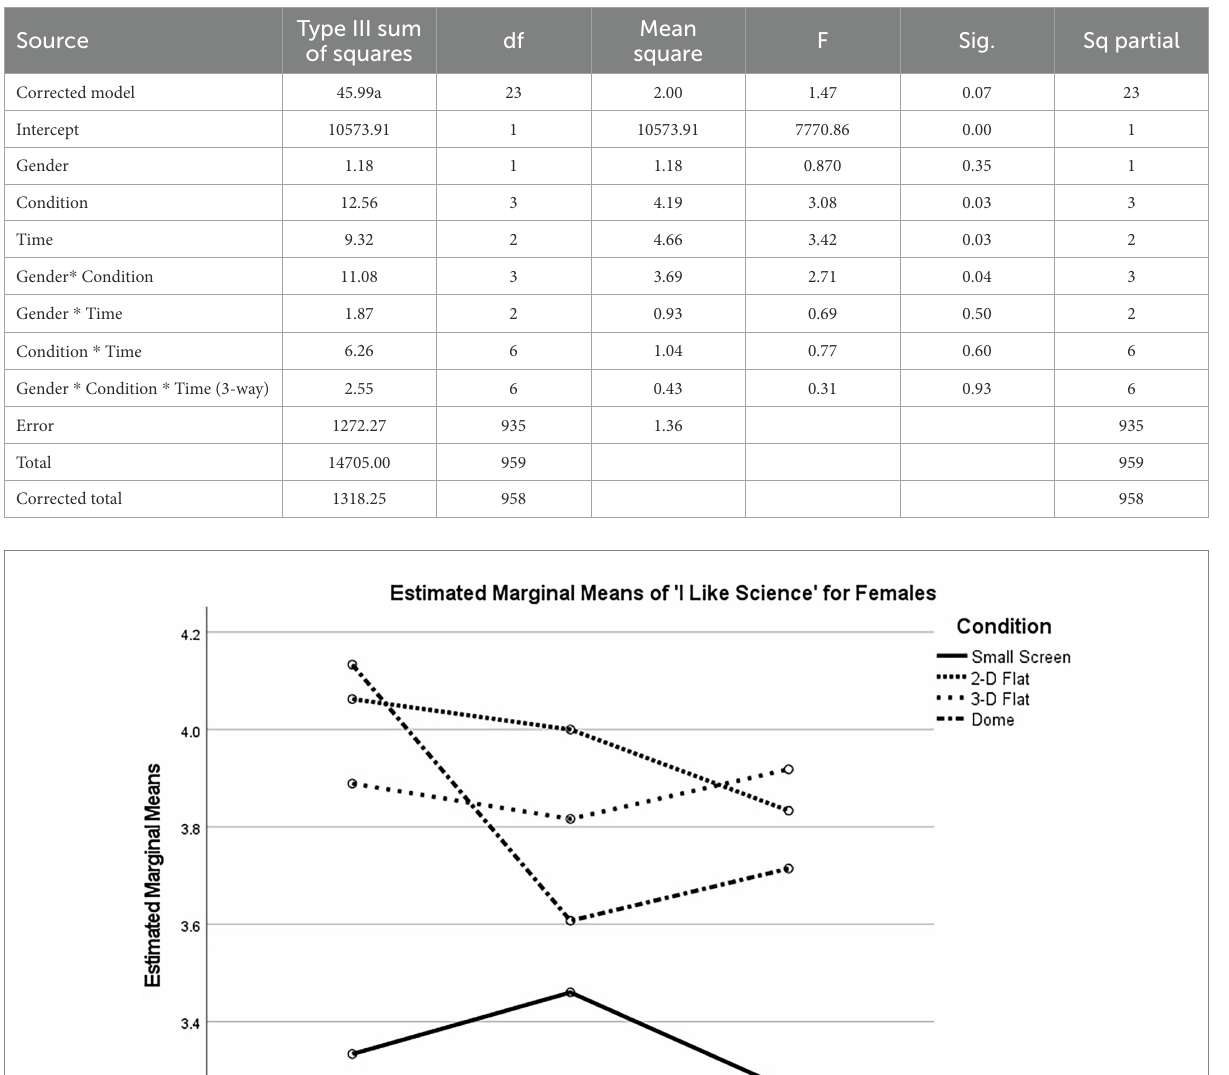
TABLE 5 I like Science – gender by condition